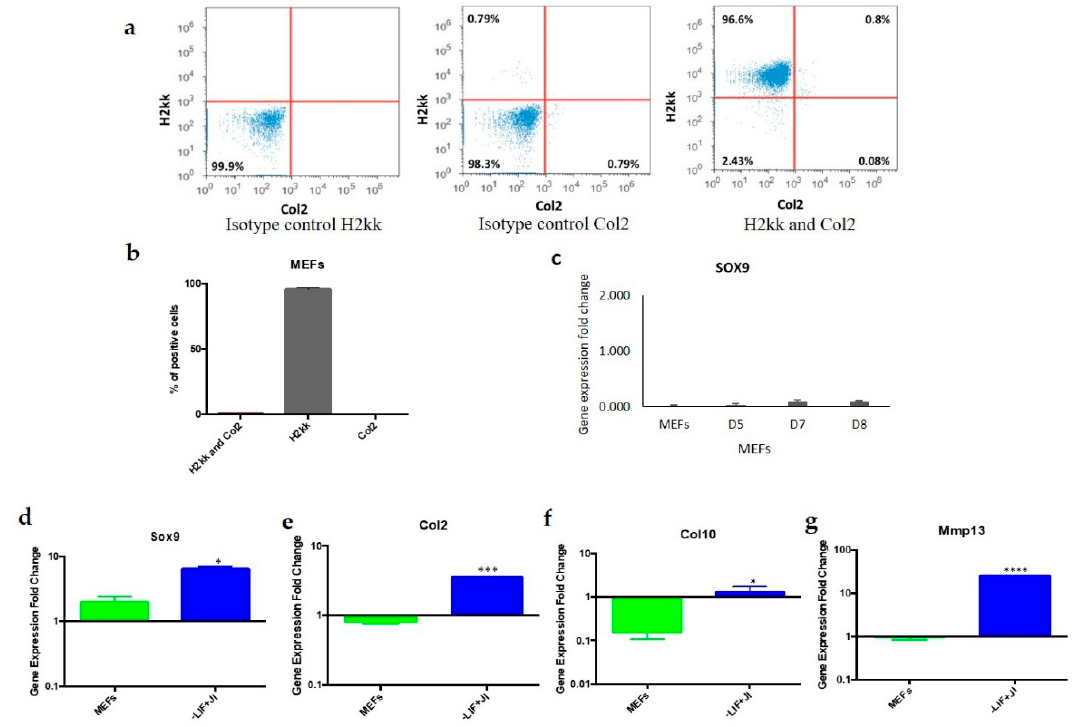
Figure 3. A negligible number of chondroblasts present in the starting MEFs population. 2-D histogram plotted with fluorescent intensity from fibroblast (MEFs) marked with H2kk (APC) and Col2 (FITC) antibodies analyzed by flow cytometry. ( a ) The horizontal-vertical lines divide the cells into four quadrants, which represent cells that were not marked or did not have an expression of those proteins (bottom left), cells with H2kk expression (top left), cells with Col2 expression (bottom right) and cells with expression of both proteins (top right). ( b ) In total, 96.6% of the MEFs population stained positive for H2kk , whereas 0.8% positive for both H2kk and Col2 . ( c ) Expression of Sox9 in MEFs cultured with chondrogenic media during di ff erent time points is comparable to control MEFs. ( d – g ) Chondroblast geneexpressionisdi ff erentintransdi ff erentiatedcellscomparedtoMEFs.